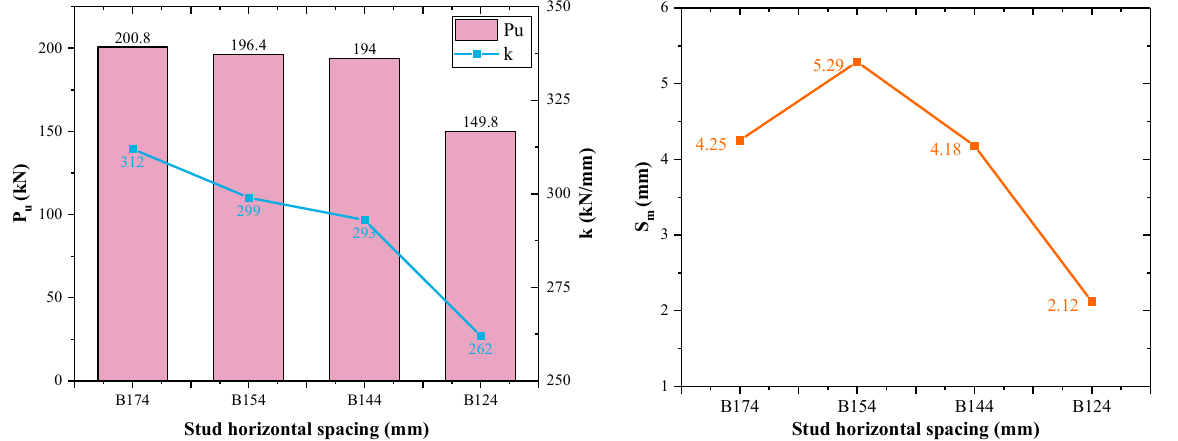
Figure 24. Influence of horizontal stud spacing on ultimate strength and shear stiffness.